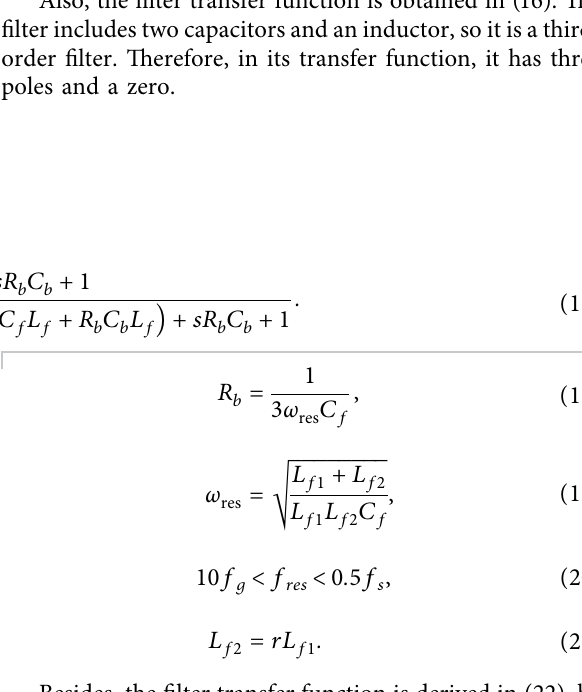
Figure 4: LC flter.